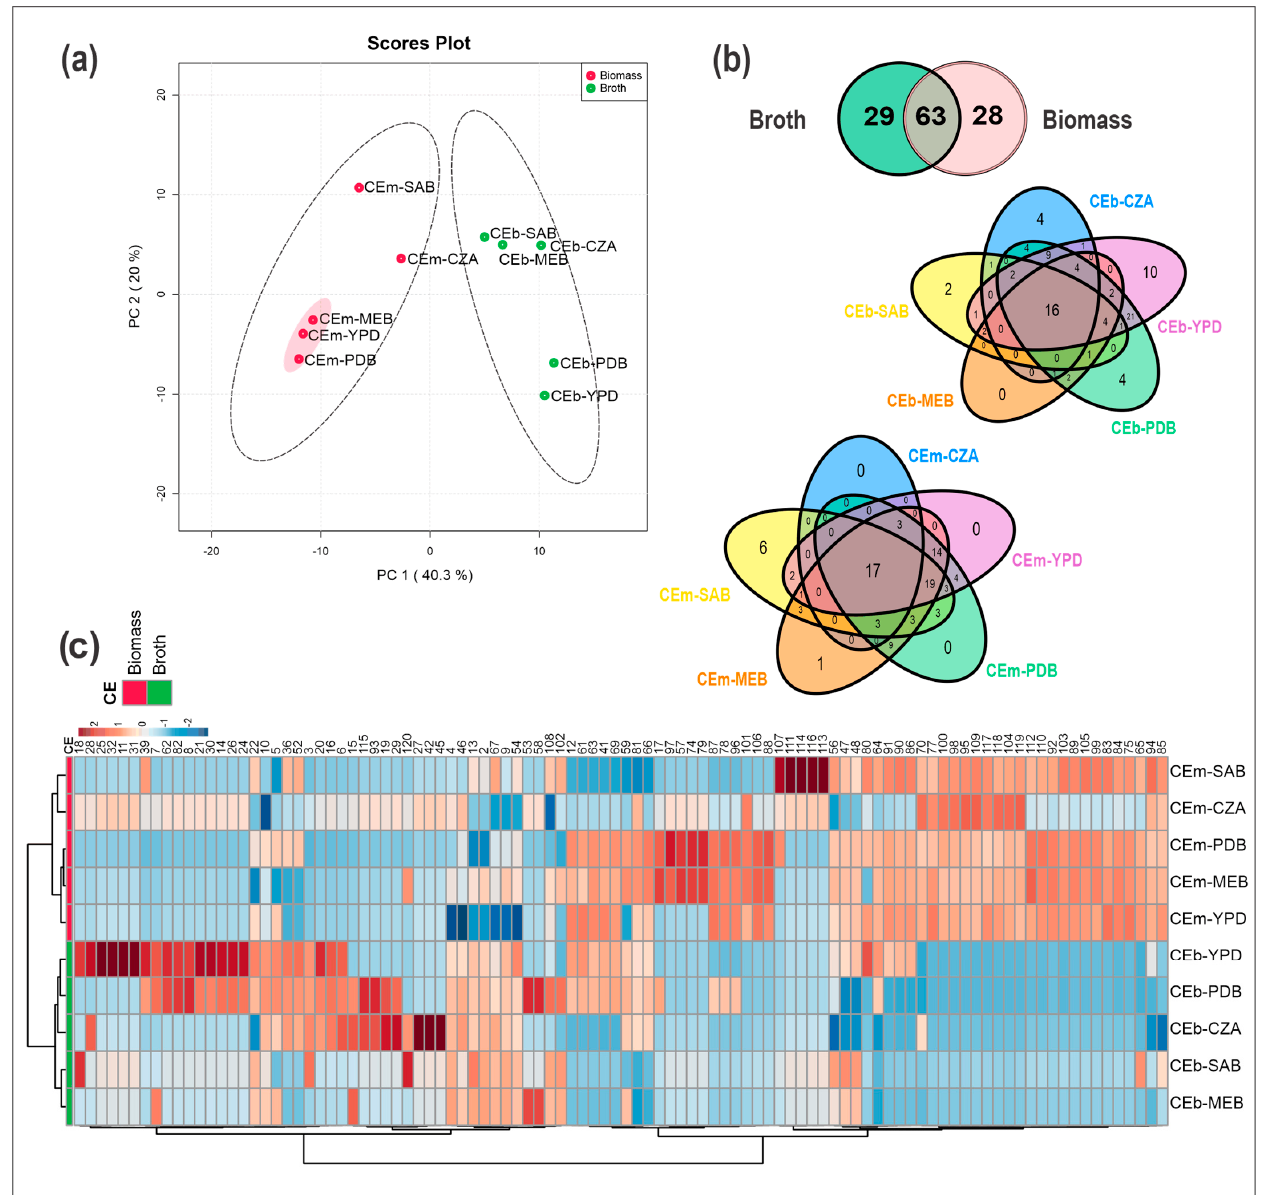
Figure 1. Metabolomic analyses from the crude extracts of mycelial biomass (CEm) and broth (CEb) of Penicillium sp. strain 5MP2F4 cultivated on different culture media (PDB, MEB, SAB, YPD, and CZA). ( a ) Principal component analysis (PCA) from all the crude extracts. The highlighted samples CEm-MEB, CEm-YPD, and CEm-PDB were the most active extracts against S. aureus. ( b ) Venn dia- gram of metabolites in CEb and CEm. ( c ) Heatmap and hierarchical clustering analysis (HCA) of the features ranging from red to blue color, representing high to low ion intensities. Groups of CEm and CEb samples are in red and green color, respectively.